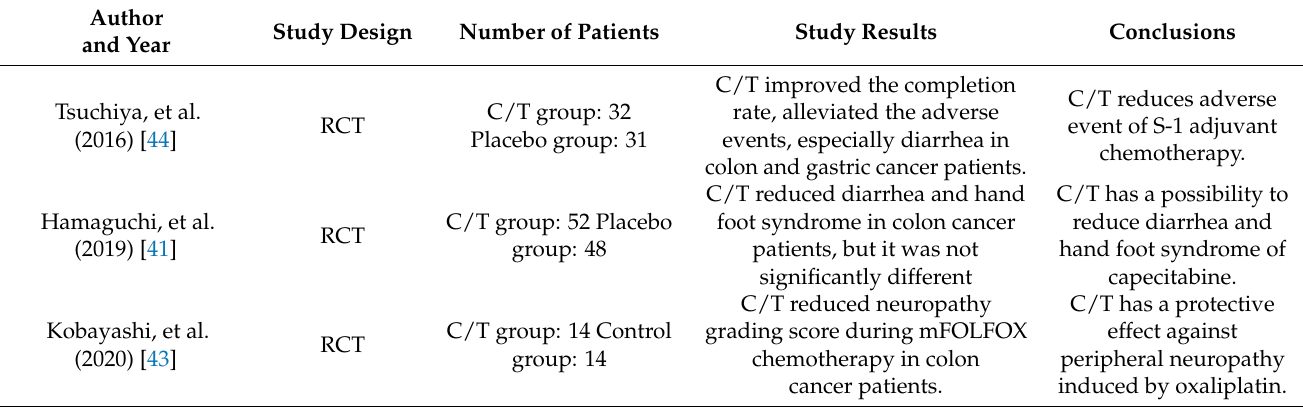
Table 3. Clinical study of cystine/theanine for adverse events of anticancer drugs.